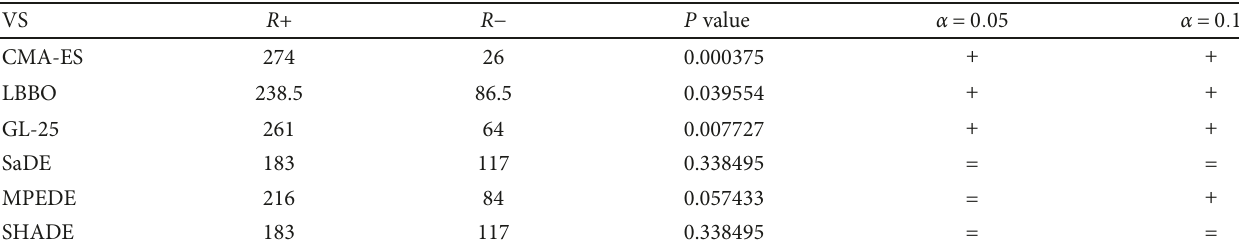
Table 11: Results obtained by the multiple-problem Wilcoxon test for DEMR and other six algorithms on